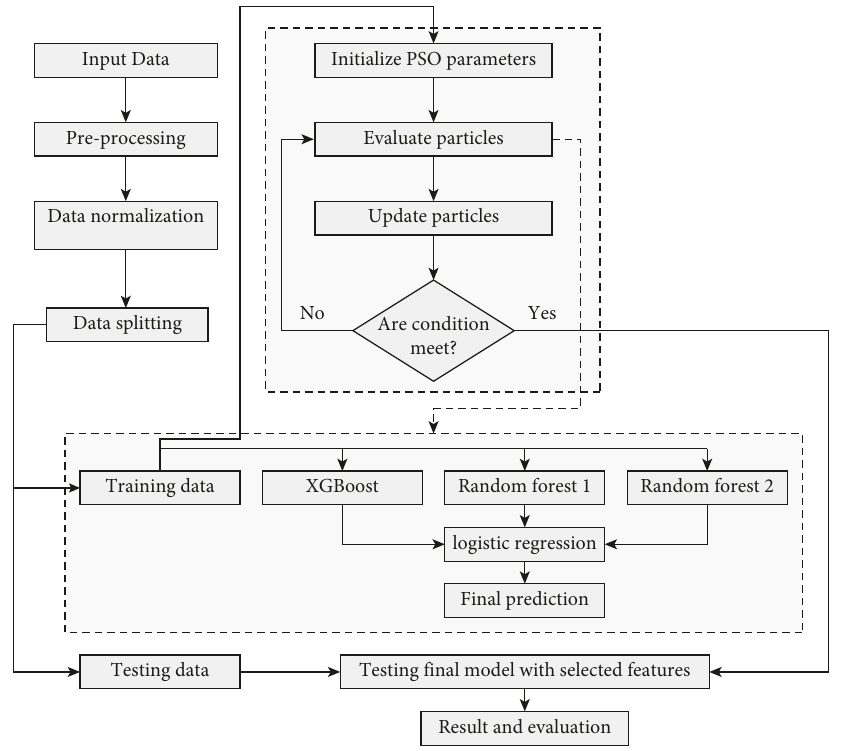
Figure 1: Proposed system. Table 2: Topological properties of networks